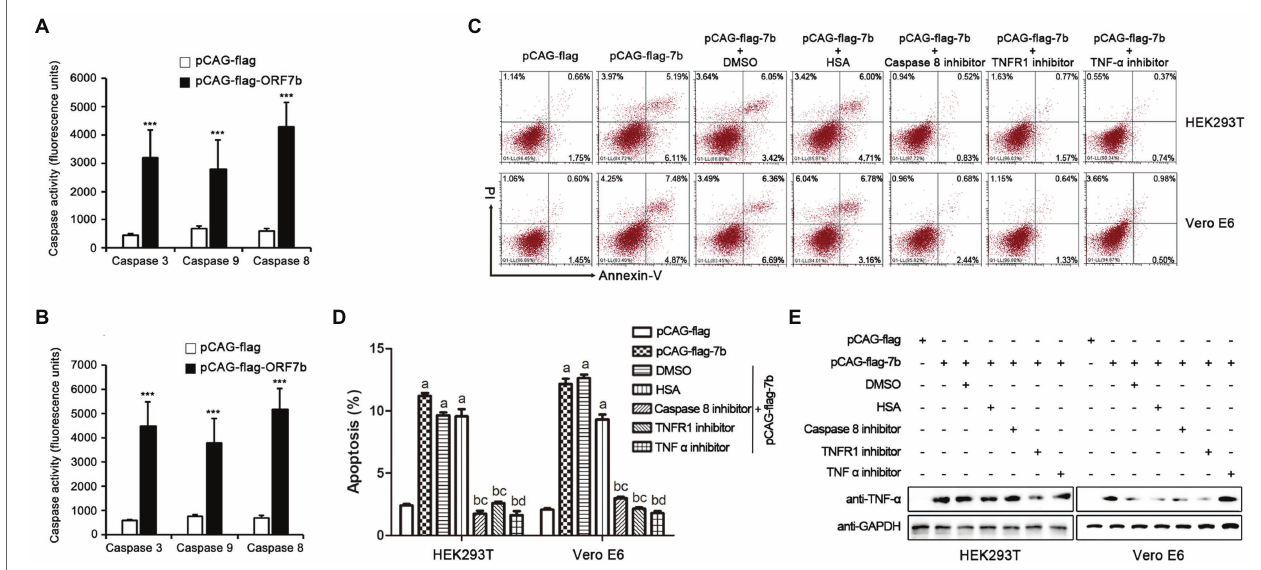
FIGURE 4 | Caspase 8, TNFR1, and TNF- α inhibitor suppress ORF7b induced apoptosis. (A) Enzyme activity changes of caspase 3, 8, and 9 in HEK293T cells after transfection with pCAG-flag and pCAG-flag-ORF7b for 18 h. (B) Enzyme activity changes of caspase 3, 8, and 9 in Vero E6 cells after transfection with pCAG- flag and pCAG-flag-ORF7b for 18 h. (C) Apoptosis in HEK293T and Vero E6 cells was detected by flow cytometry after transfected with pCAG-flag/pCAG-flag- ORF7b or treatment with Caspase 8 inhibitor, TNFR1 inhibitor, and TNF- α inhibitor for 18 h. DMSO and HSA were set as the controls for Caspase8/TNFR1 inhibitor and TNF- α inhibitor groups, respectively. (D) The percentage of apoptosis was calculated from three independent experiments. a, vs. pCAG-flag group, ***; b, vs. pCAG-flag group, n.s; c, vs. pCAG-flag-ORF7b plus DMSO group, ***; and d, vs. pCAG-flag-ORF7b plus HSA group, ***. (E) The expression level of TNF- α was detected by Western blotting after treatment for 18 h. Data are shown as mean ± SD, n = 3. *** p < 0.001 and n.s, means no significant difference, compared with the relative control group. Student’s t -test was used for analysis of A,B ; one-way ANOVA and Tukey’s post-hoc test were used for D .